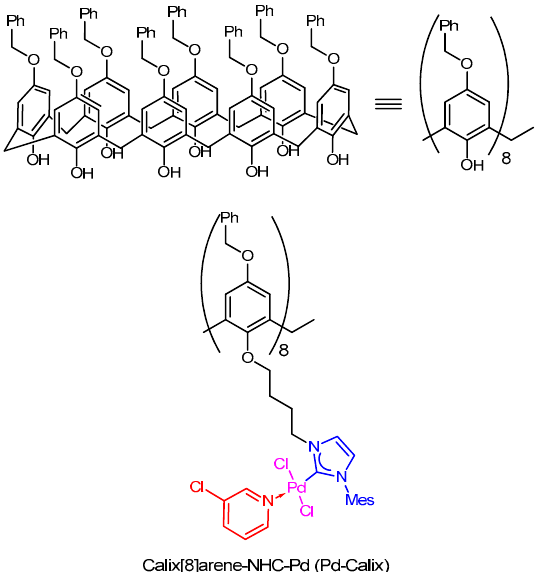
Figure 1. General structure of calix [8]arenes (top) and structure of the calix[8]arene bearing eight NHC-palladium units (Pd-Calix) (bottom). Mes = Mesityl.